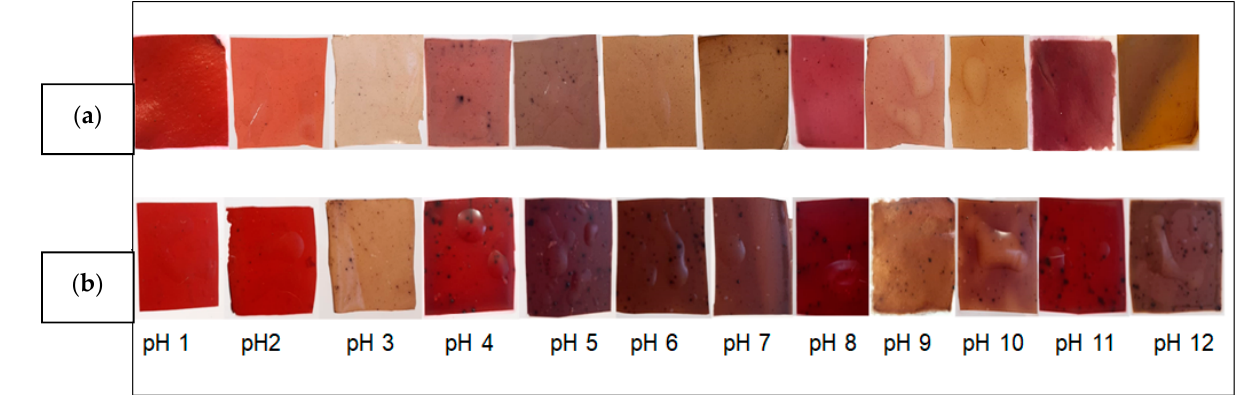
Figure 3. Visual changes in ( a ) CAR–50% JPE and ( b ) CAR–100% JPE films at different pH buffer solutions.